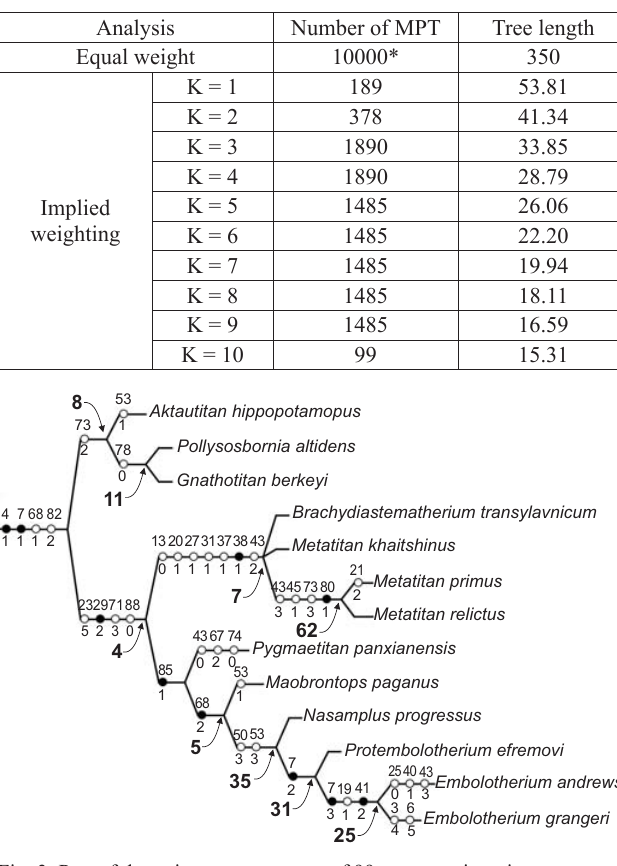
Fig. 3. Part of the strict consensus tree of 99 most parsimonious trees pro- duced by TNT implied weighting character analysis (K = 10), showing the interrelationships within the infratribe Embolotheriita Osborn, 1929a sensu Mihlbachler (2008). Only unambiguous characters are shown (black circles are nonhomoplasies and white circles are homoplasies). The num- bers next to the circles are characters (above) and states (below). The num- bers at nodes in bold face are GC values for branch support.